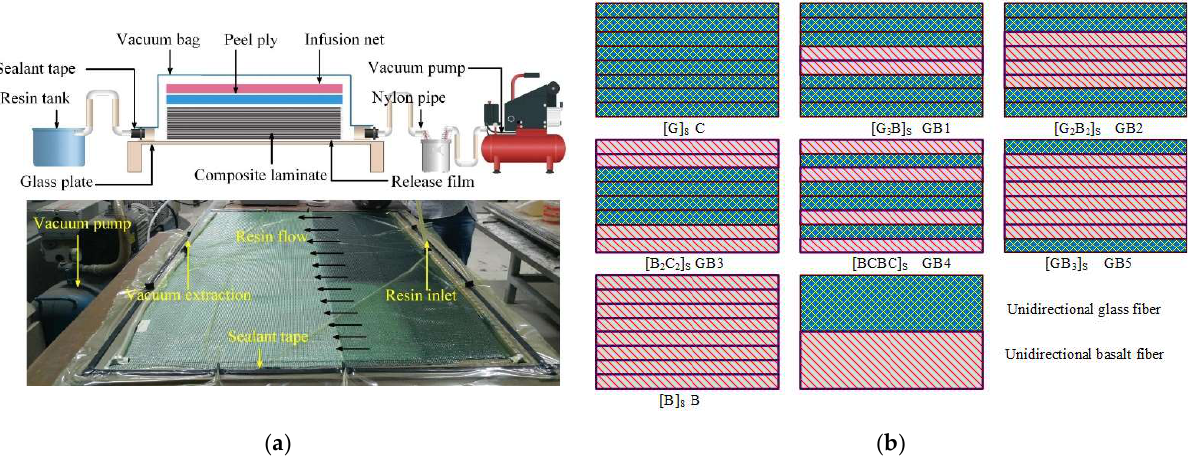
Figure 1. ( a ) Photograph and schematic illustration of VARI processing and ( b ) stacking sequence of laminates.